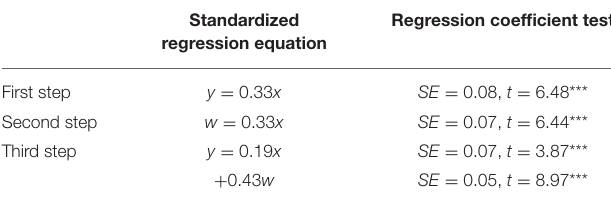
TABLE 4 | Examination of the mediating effect of amount of exercise